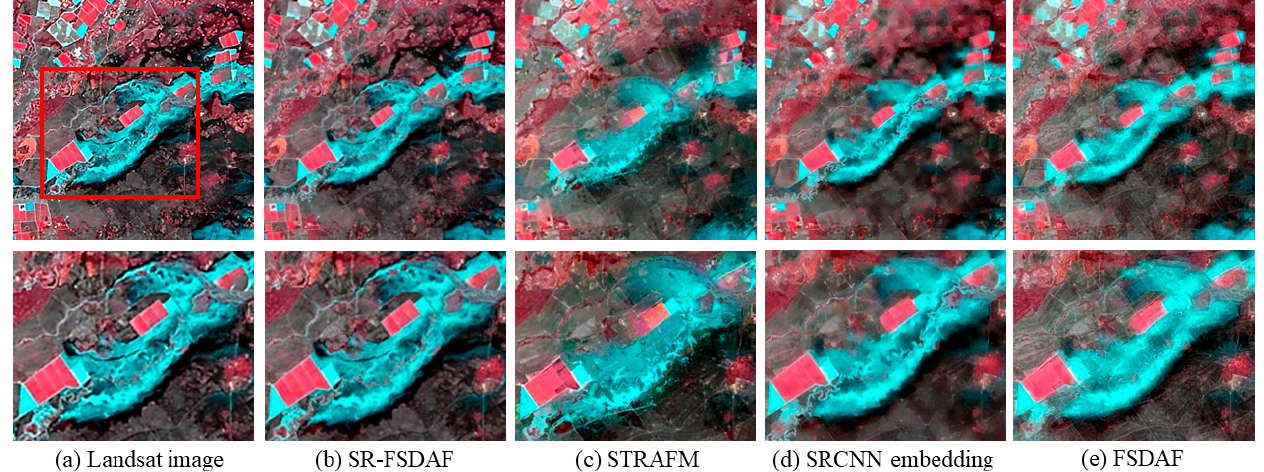
Figure 5. Comparison of the fused image and original Landsat image of heterogeneous mutations. ( a ) The Original Landsat image. ( b ) Fused image based on the SR-FSDAF method. ( c ) Fused image based on the STARFM method. ( d ) Fused image based on the SRCNN embedding method. ( e ) Fused image based on the FSDAF method.